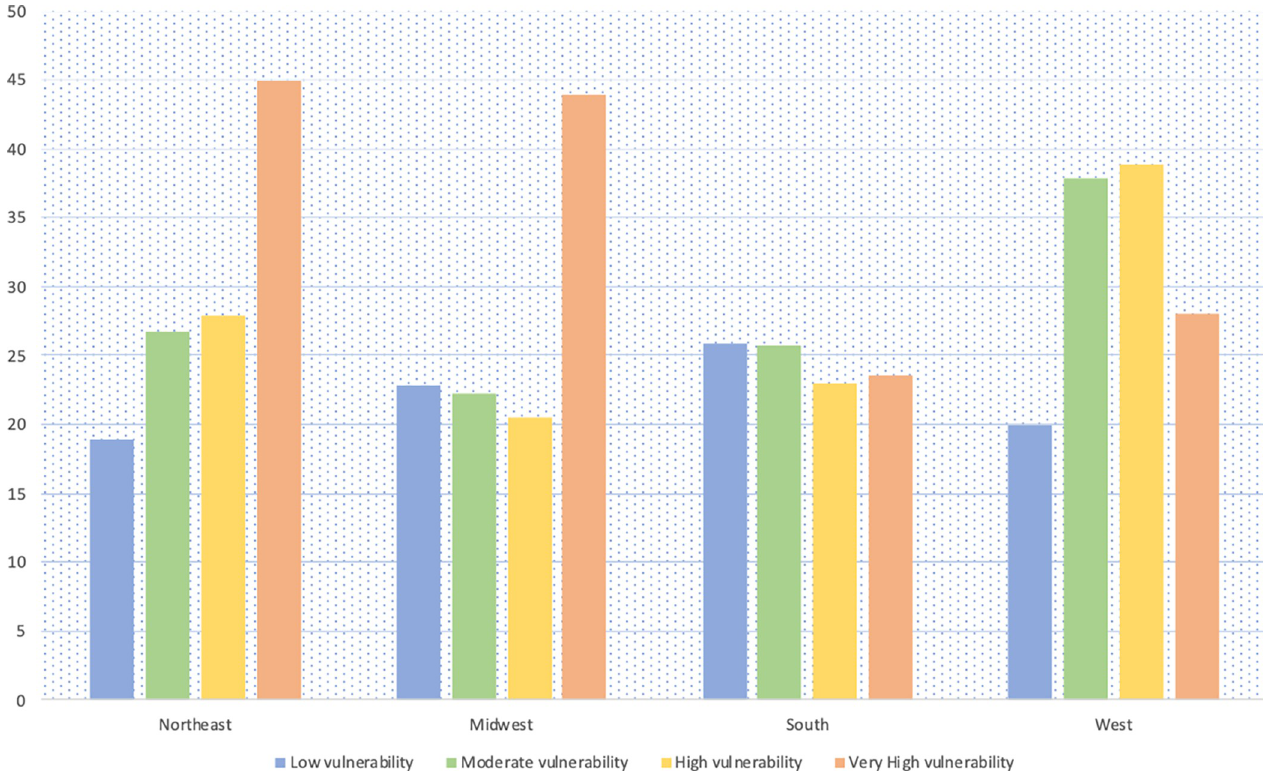
Fig 3. Unadjusted mortality rates (%) per 100 hospitalized COVID-19 patients by neighborhood type.